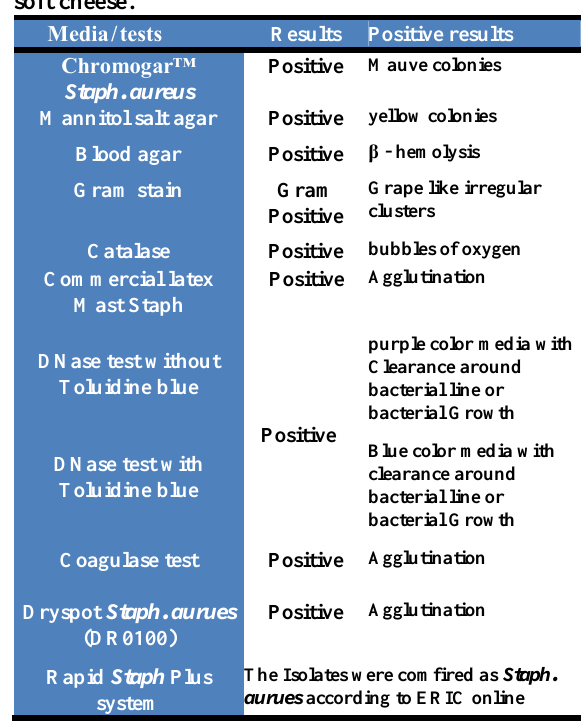
Table, 1: The Cultural, Biochemical and serological properties of Staphylococcus aureus isolates from